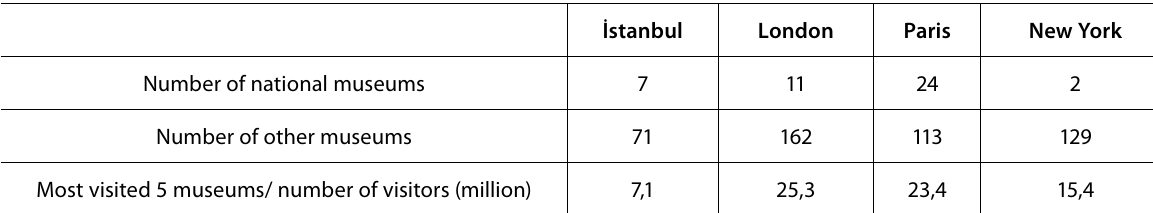
Most visited 5 museums/ number of visitors